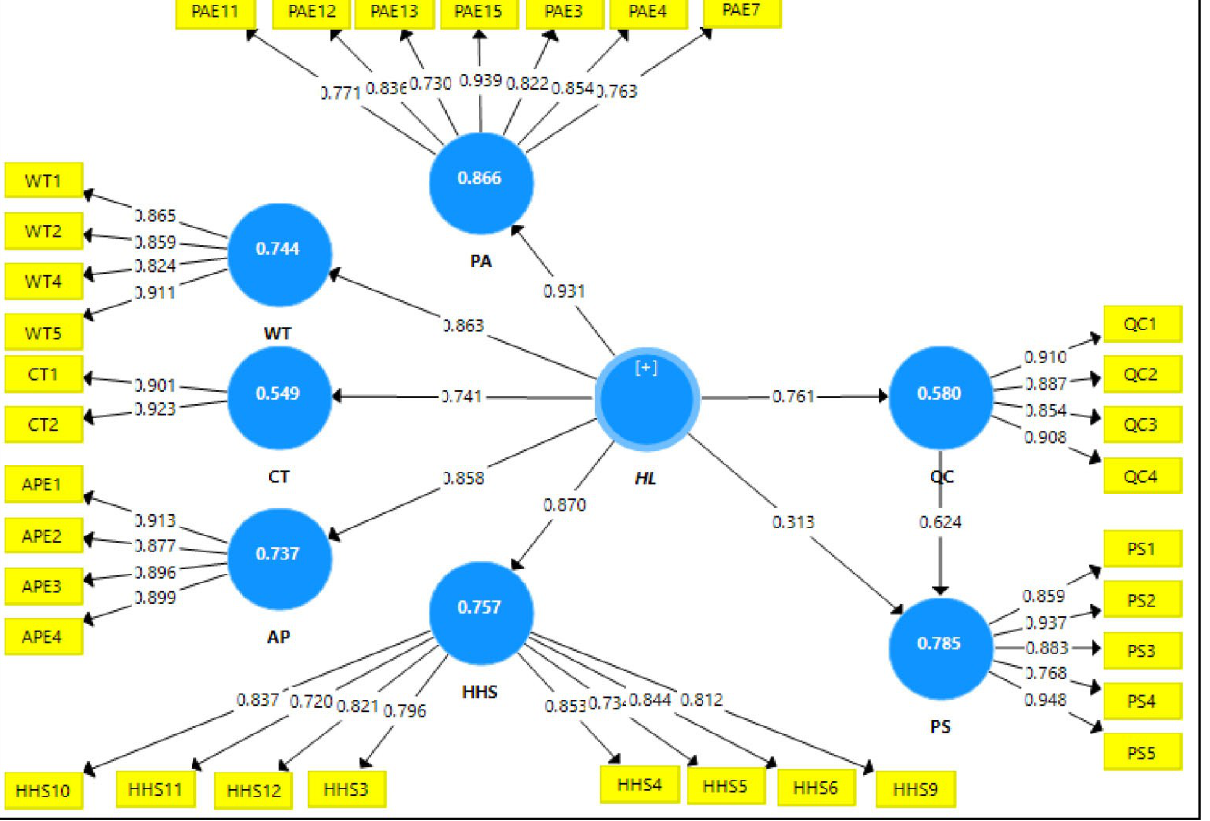
Figure 3. UPC final SEM-PLS